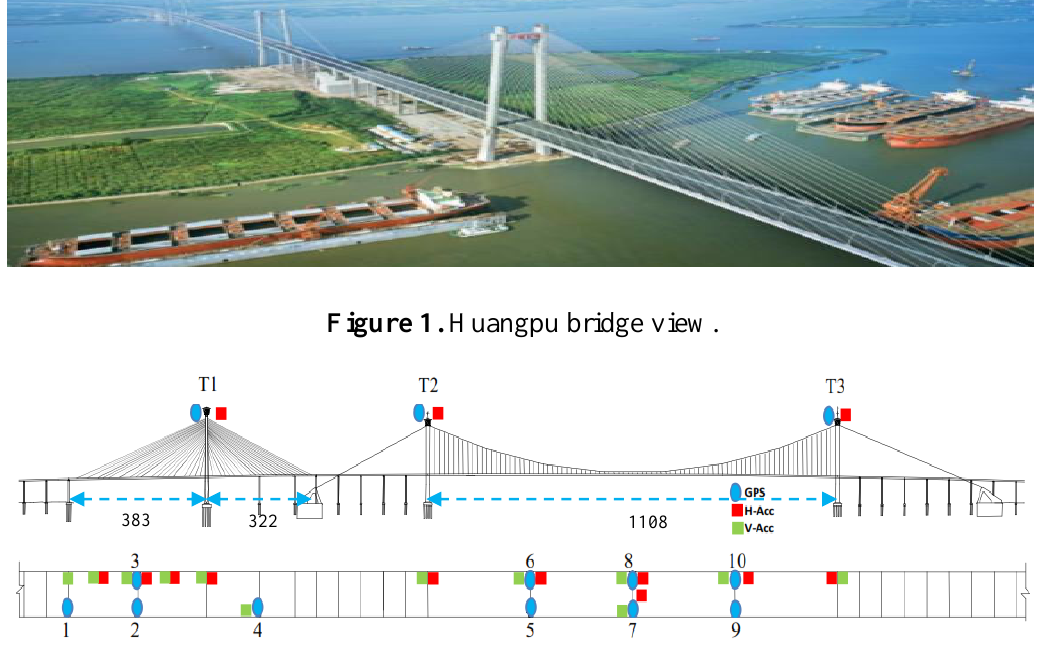
Figure 2. Bridge elevation and health monitoring